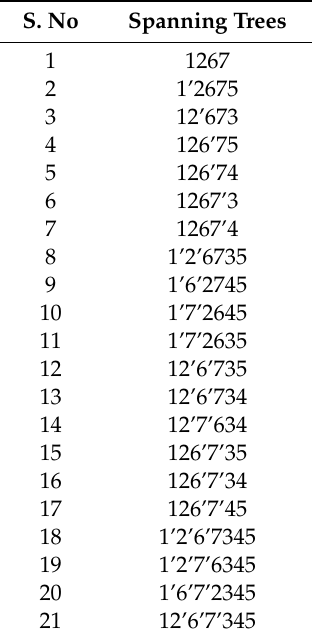
Table 2. Disjoint spanning trees (St i